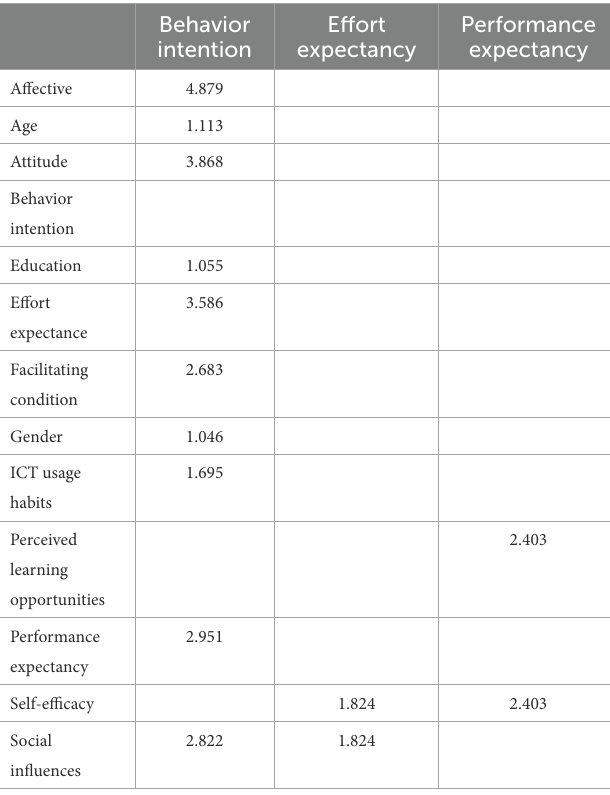
TABLE 6 Variance inflation factor (VIF) value. Behavior